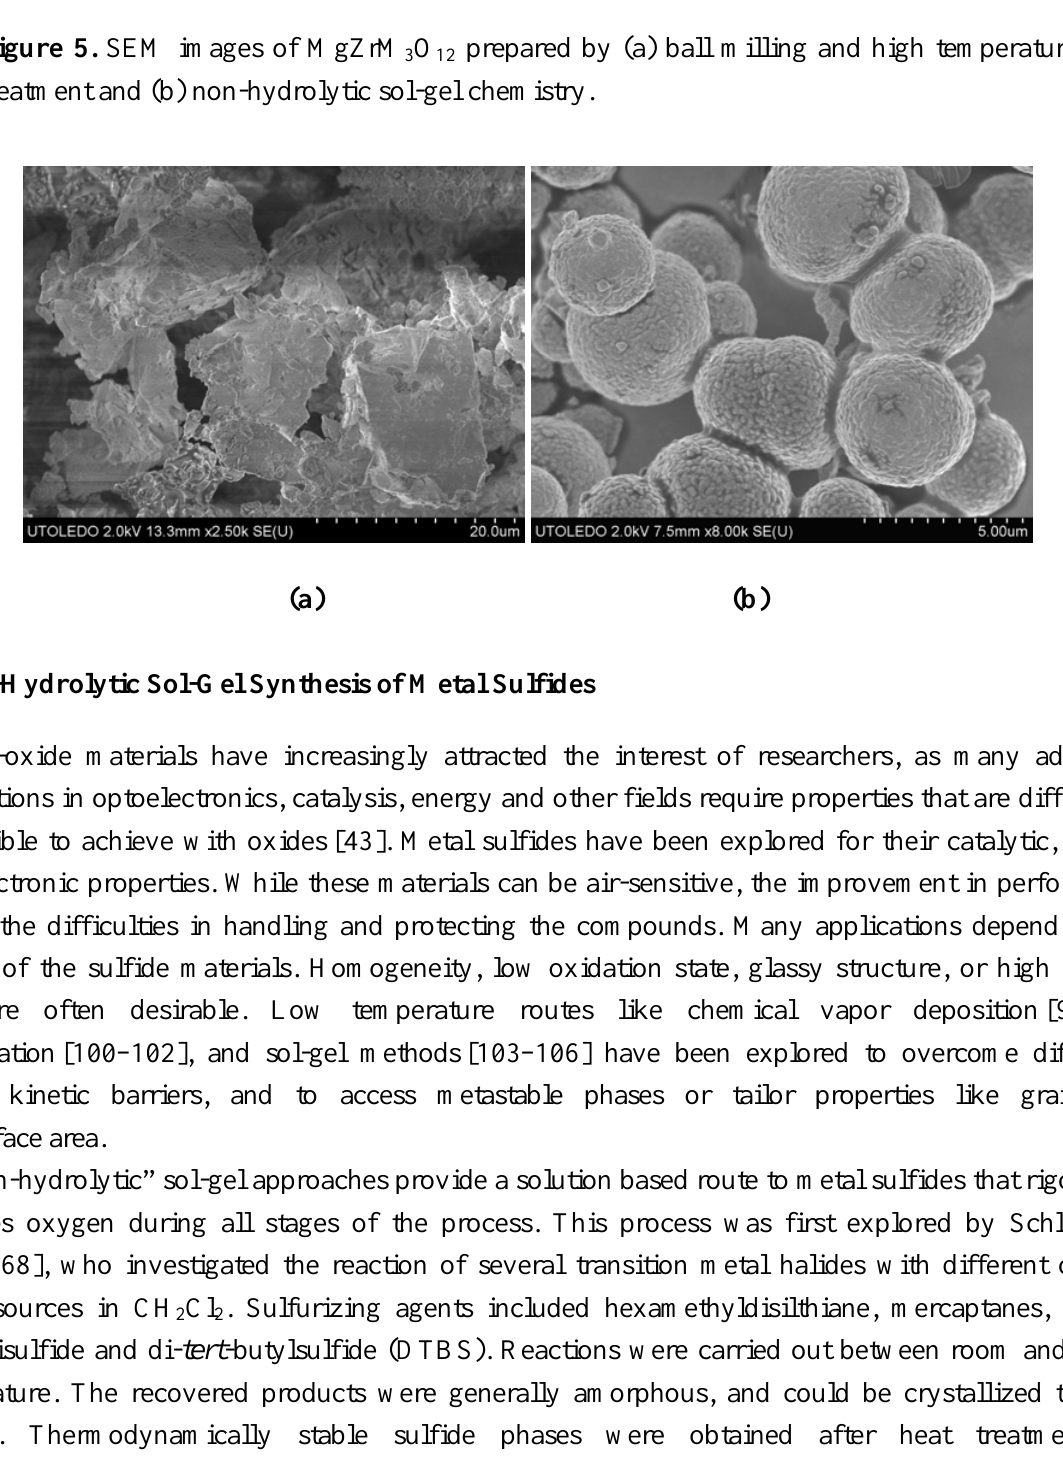
O prepared by (a) ball milling and high temperature 3 12